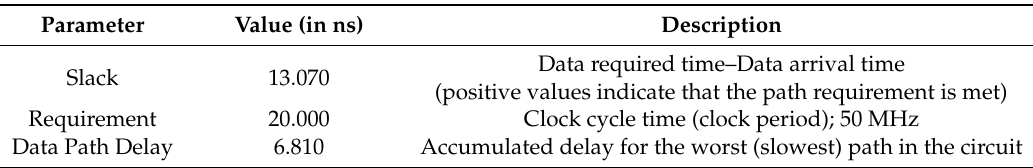
Table 1. Timing results (summary).